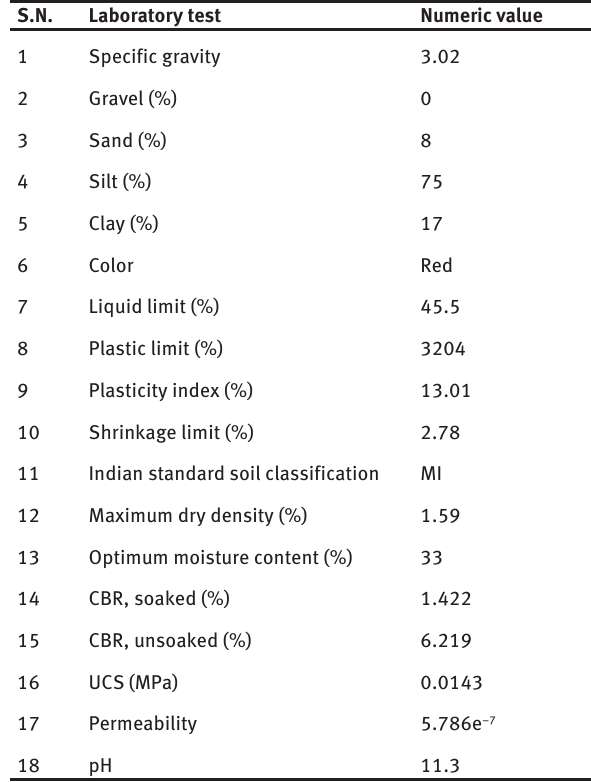
Figure 5: (a) SEM image of tested clay without stabilization and the microstructure. (b) SEM image of the fractured surface of a clay–polymer nanocomposite. Table 3: Physical and chemical properties of Eko soil enzyme source [74].